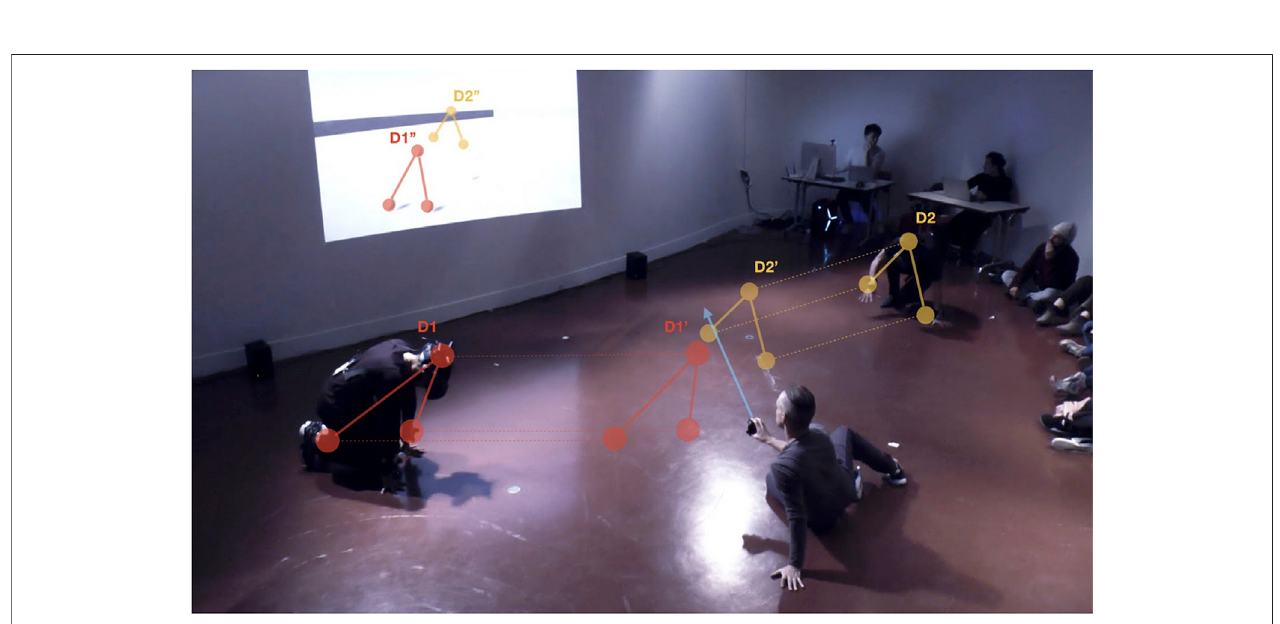
FIGURE 14 | Picture from the ENSAD performance in Paris. D1 and D2 show the sensor positions of the two performers on the stage; D1 ′ and D2 ′ simulate the positions of the performers in the virtual shared space; D1 ″ and D2 ″ show the performers position in the virtual space, on a projected picture framed by the